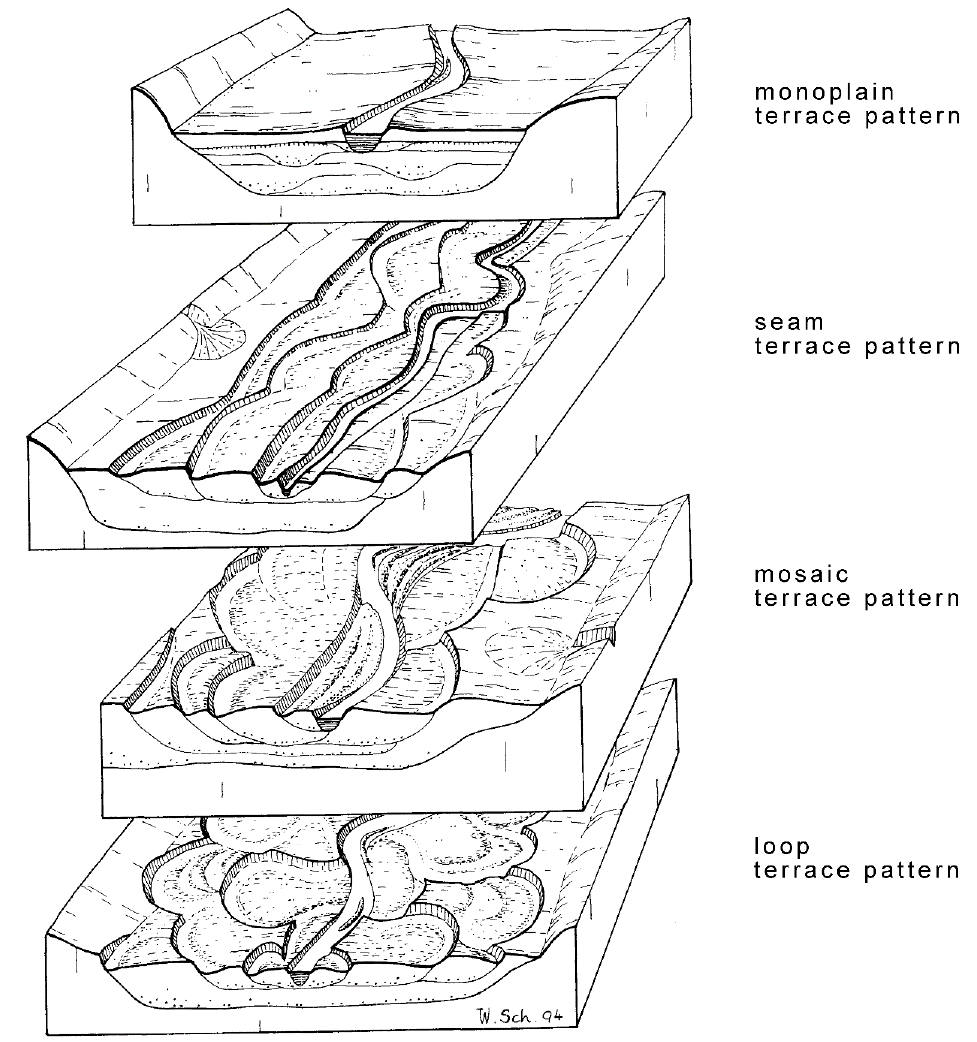
Figure 15. Terrace patterns in the valley bottom.